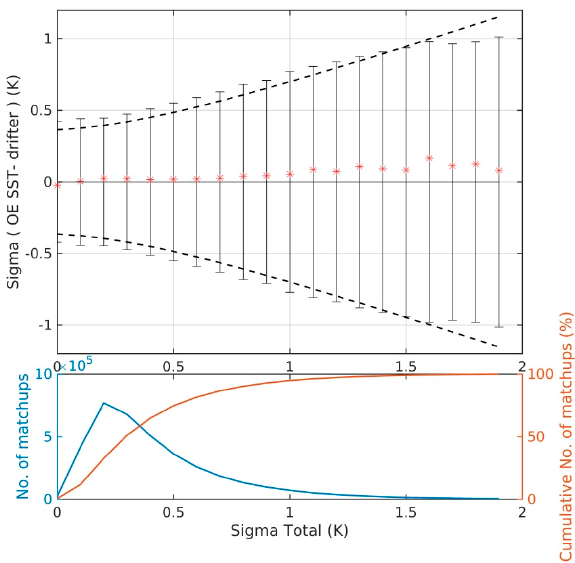
Figure 11. OE SST uncertainty validation with respect to drifter SST. Dashed lines show the ideal uncertainty model accounting for uncertainties in drifter SST and the sampling error. Solid black lines show one standard deviation of the retrieved minus drifter differences for each 0.1 K bin and the red symbols mark the mean bias. The bottom plot shows number of matchups (blue) and the cumulative percentage of matchups for each bin (red).